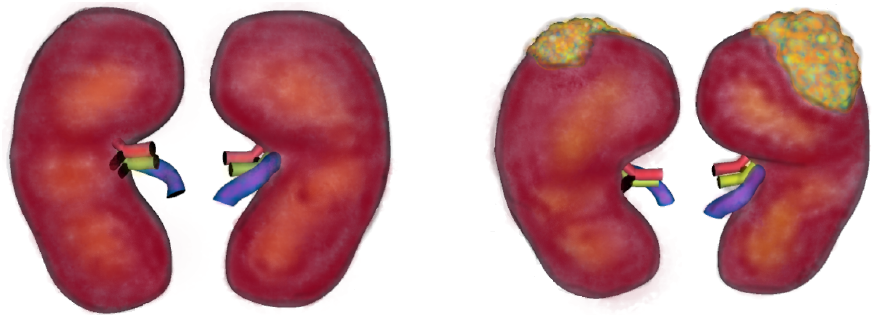
Figure 1. Illustration of healthy kidneys and kidneys with